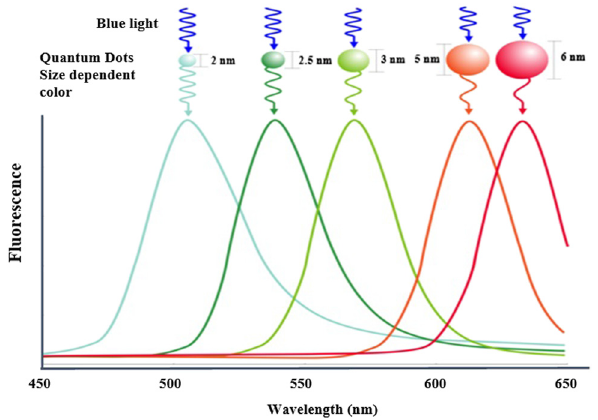
Figure 1: Variation in QD colors with their size [ 13 ] .